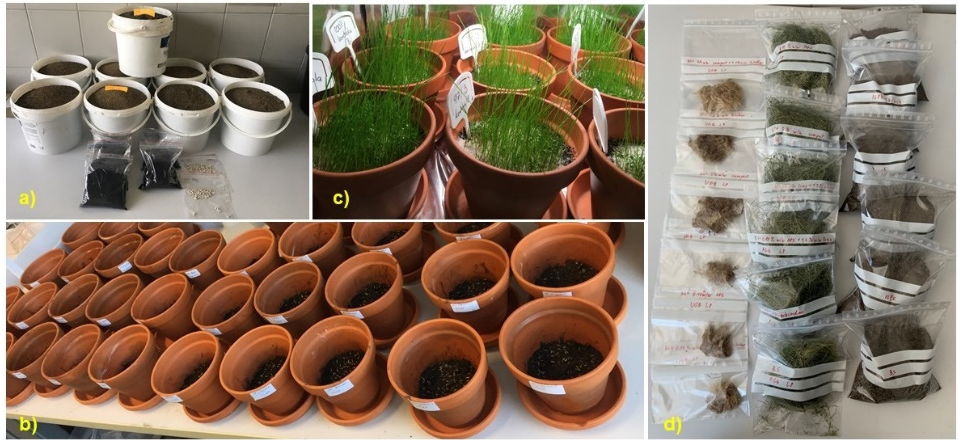
Figure 3. ( a ) Burnt soil with soil amendments before mixing; ( b ) terracotta pots; ( c ) Lolium perenne biomass growth; ( d ) dried and packed AGB, UGB, and soil after pot experiment.